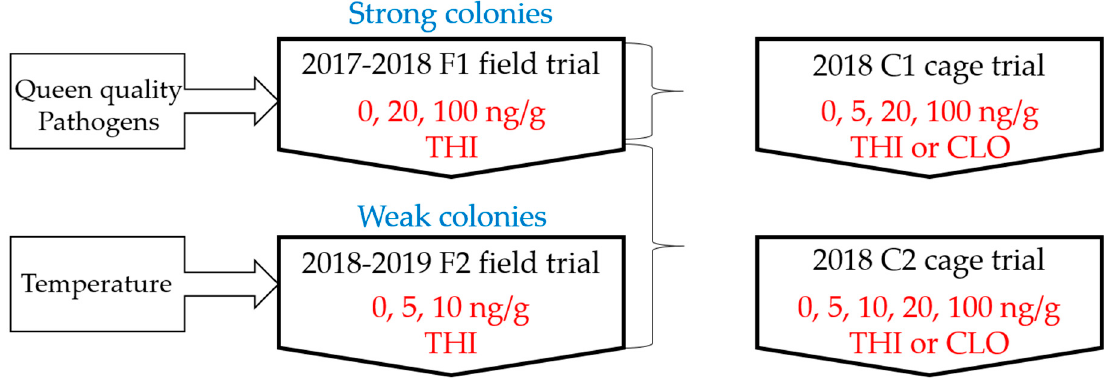
Figure 1. Experimental design of field and laboratory cage trials. Field trials examined the effects of chronic overwinter exposure to thiamethoxam (THI) on survival of strong colonies (F1) or weak colonies (F2), as well as sublethal effects on queen quality and pathogen load (F1) and colony temperature regulation (F2). Cage trials examined the effects of chronic exposure to THI or its metabolite clothianidin (CLO) on laboratory survival of winter adult workers.